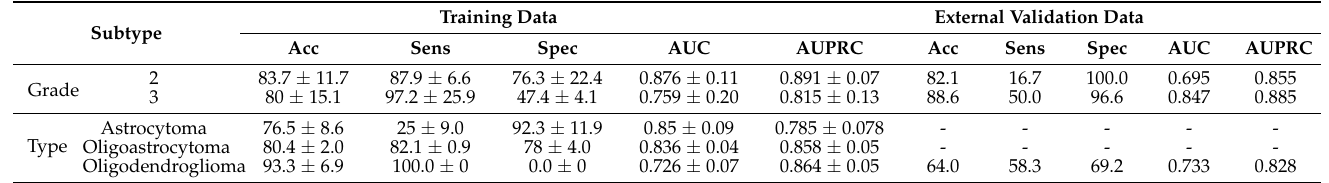
Table 4. Performance results of our model on different patient subgroups. The final model used XGBoost algorithm and top seven features. The results show that we had promising performance on cross-grade and cross-tumor subtype problems.